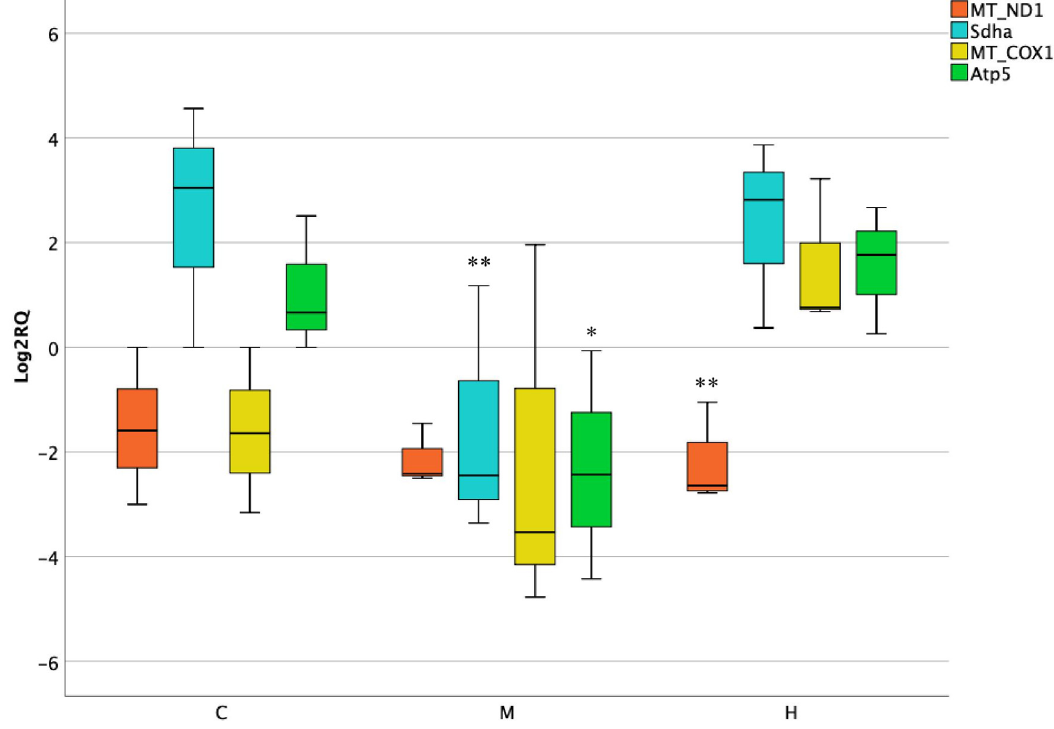
Figure 1. Box plot showing relative expression of mitochondrial and nuclear encoded genes in stomach when compared to control C1 (Log2RQ = 0) to medium treatment (M) and high treatment (H) by quantitative PCR (qPCR). RQ, relative quantification. The box plots show the median value (horizontal line), the top and bottom edges of the boxes (75% and 25% percentiles) and whiskers, which are the furthest values away from the boxes that are not considered outliers. * p < 0.05; ** p < 0.01 significantly different from the